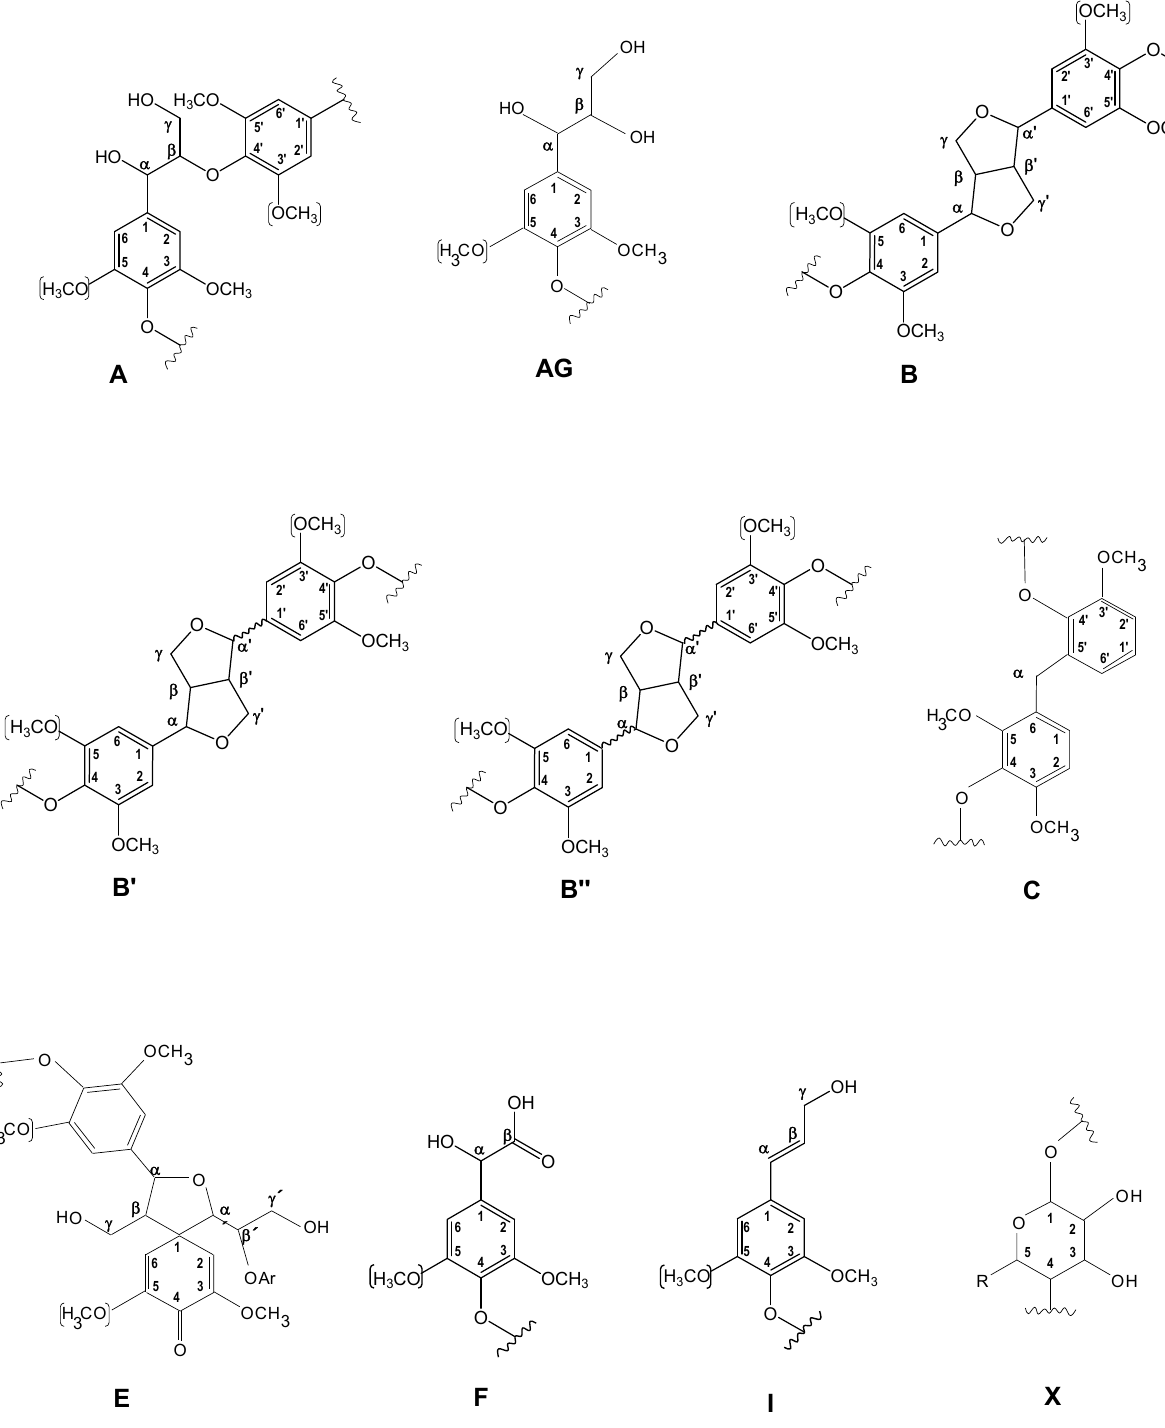
Figure 2. Main lignin and carbohydrate substructures identified in aliphatic oxygenated region of untreated and laccase ‐ treated Kraft lignins with MtL and SiLA laccases. A , β‐ O ‐ 4 ′ alkyl ‐ aryl ether; AG , aryl ‐ glycerol; B , resinols; B ′ , epiresinols; B ′′ , diaresinol; C , α‐ 5´; E , spirodienones; F , Ar–CHOH–COOH; I , cinnamyl alcohol end ‐ groups; X , xylopyranose (R, OH).